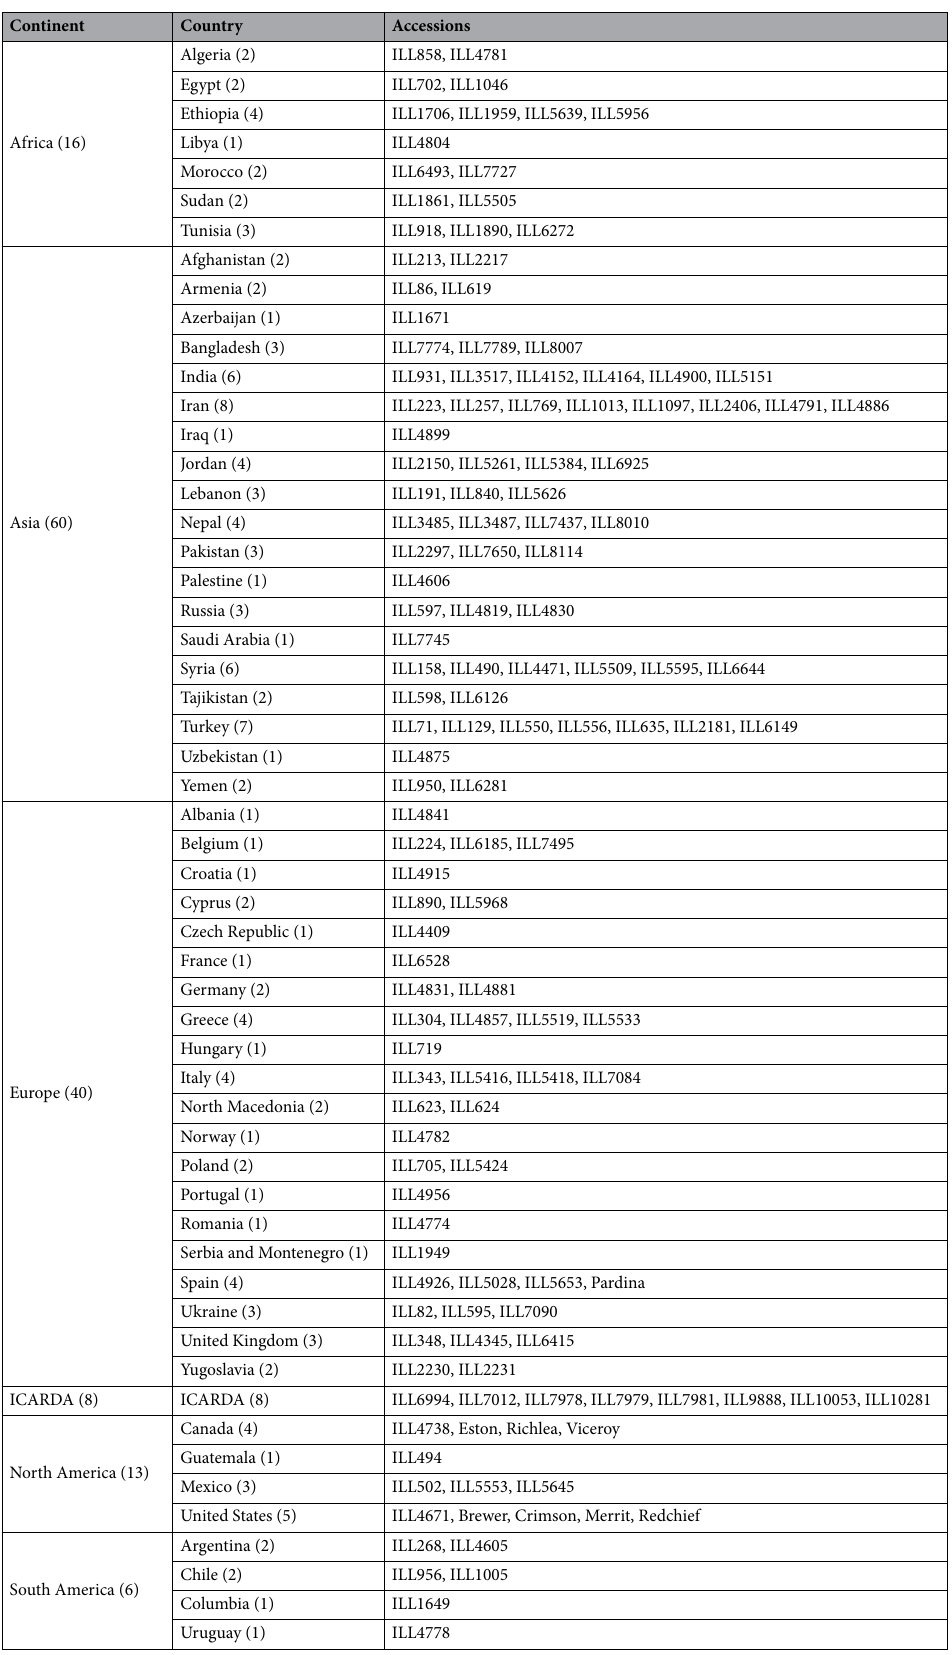
Table 1. Lens culinaris ssp. culinaris population origin information. Numbers in parentheses are accession counts per